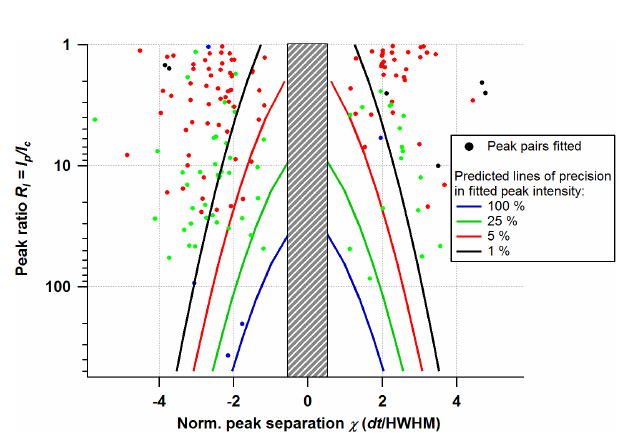
Figure 6. Ratio of fitted peak intensities to true peak separation for the smaller ion from all pairs of ions used in analysis of the CalNex field campaign data from a high-resolution aerosol mass spectrometer (Hayes et al., 2013). Superimposed are lines of con- stant estimated precision on fitted peak intensity. The data points are coloured according to the precision in fitted peak intensity expected from counting statistics. The data-point spacing is 0.2ns, and peak width is